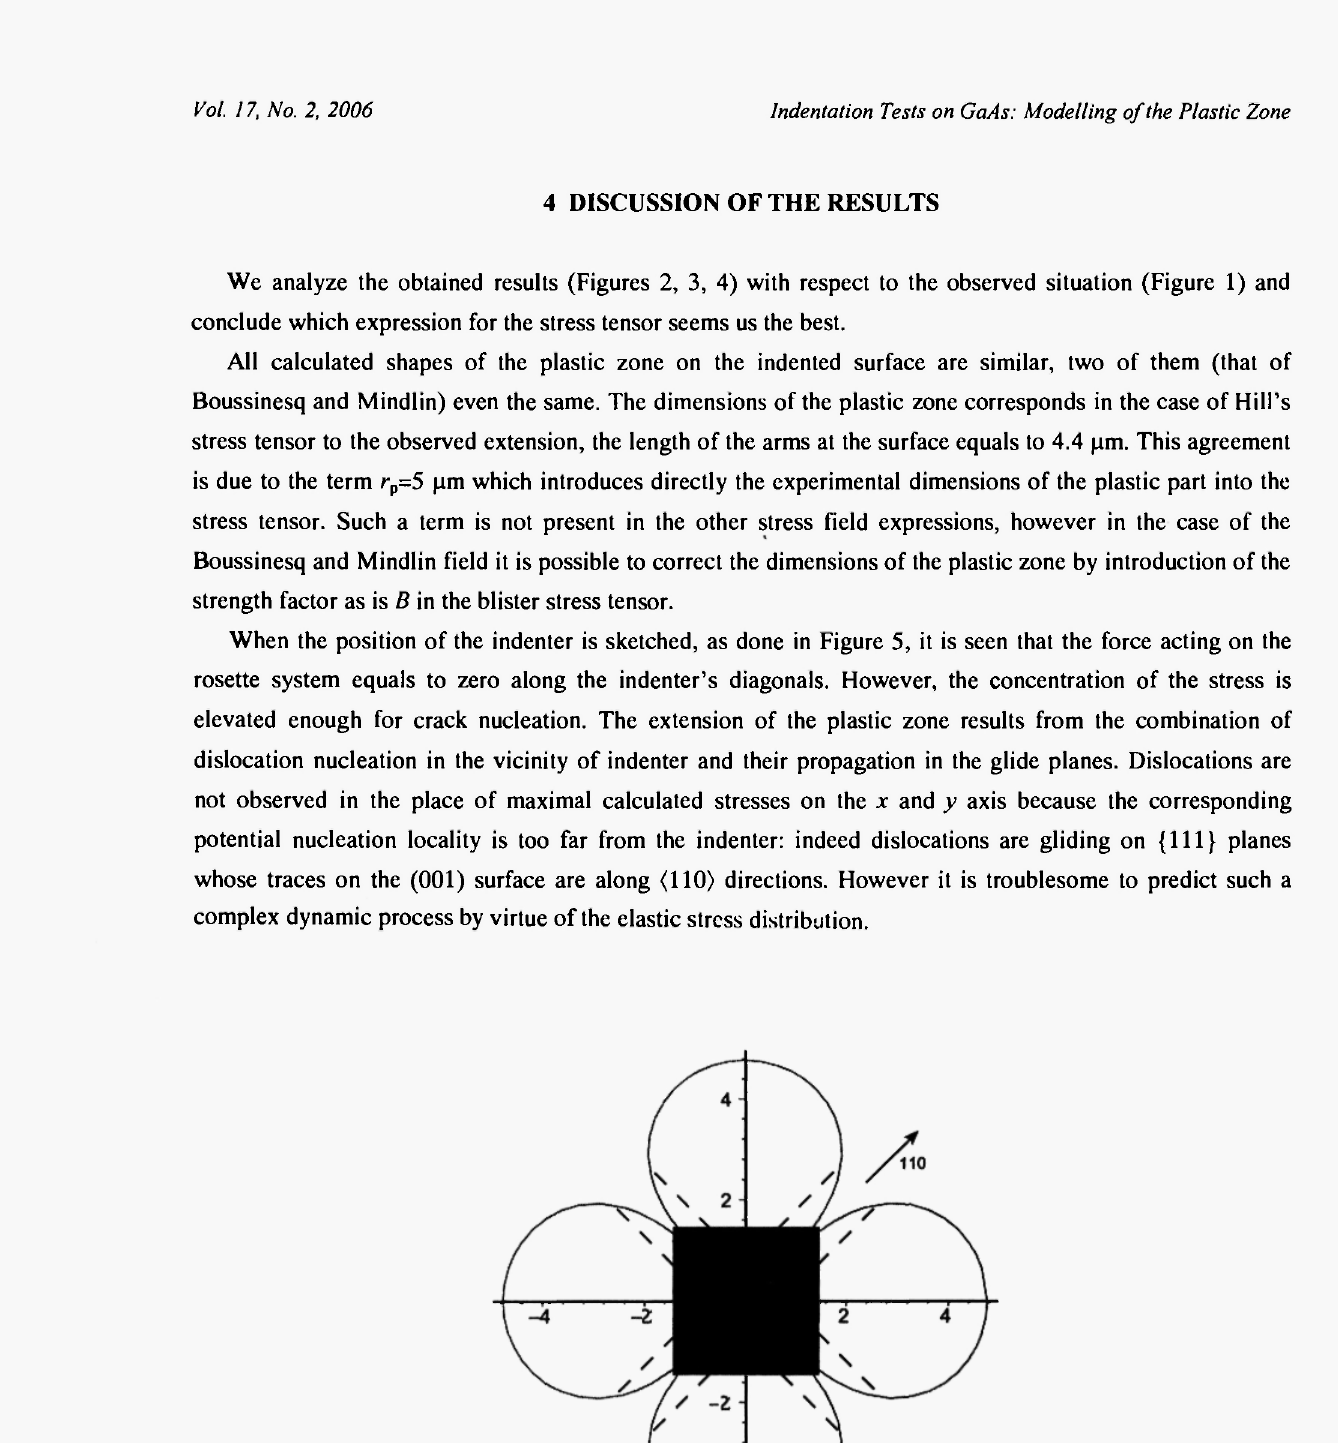
Fig. 5: Calculated extension of the rosettes on the surface with the stress field of Hill. The indenter position and the observed directions of rosette perfect dislocations are sketched. Dimensions are in